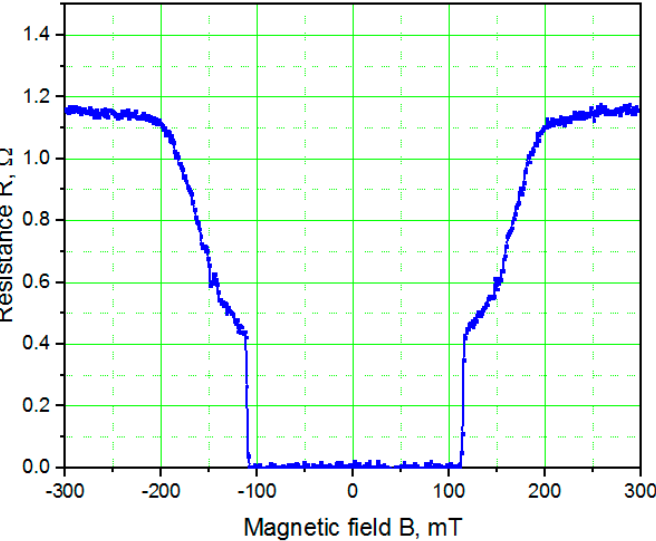
Figure 4. Magnetoresistance R ( B ) of a 100-nm-thick TiN film recorded at 1.8 K. The magnetic field was oriented perpendicular to the surface of the film.